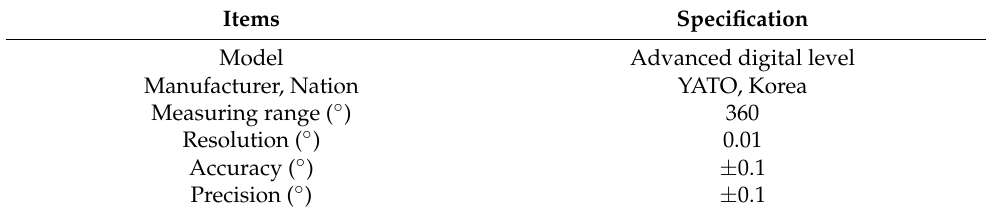
Table 5. Specifications of the digital level.